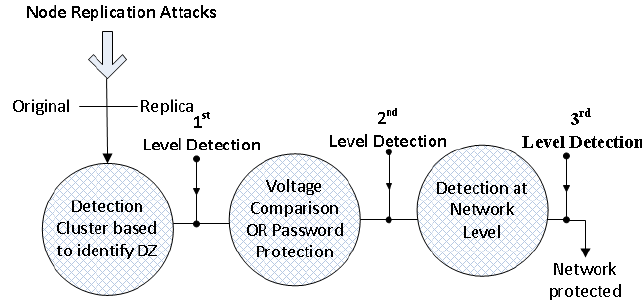
Figure 2. Clone Detection Stages in